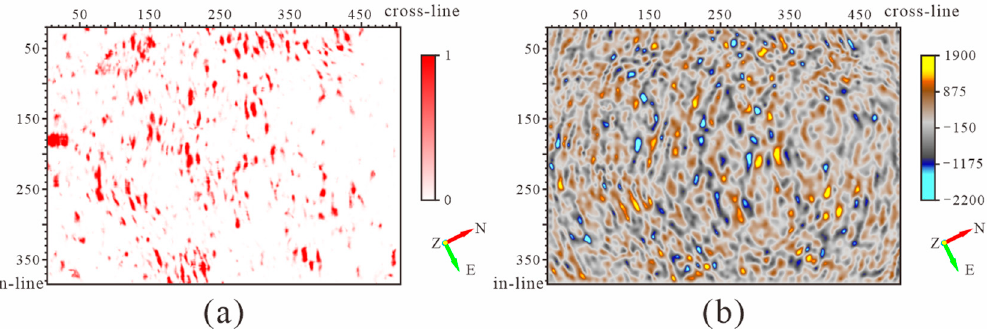
Figure 9. ( a ) The fracture distribution map of the test slice manually marked with the diffraction attribute data. ( b ) The test slice’s diffraction amplitude. The artificially labeled tags combine four